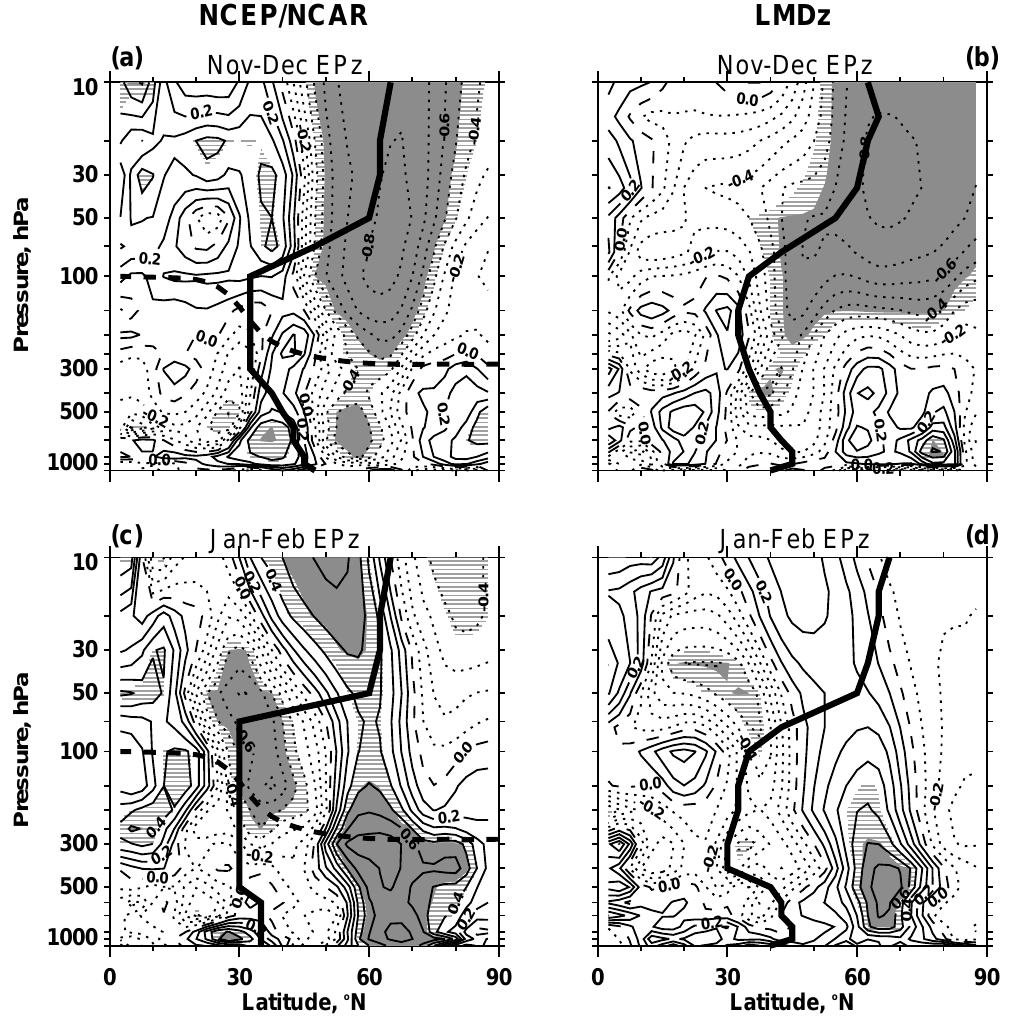
Fig. 5. Correlation between the December–January NAM index at 20hPa and the vertical EP flux ( F (z) ) anomalies. (a–b) F (z) is averaged over November–December; (c–d) F (z) is averaged over January–February; (a–c) NCEP-NCAR reanalysis; and (b–d) LMDz-GCM. The thick black line is the position of the maximum zonal mean zonal wind at each level and the dashed line is the tropopause. Contours and shading as in Fig.